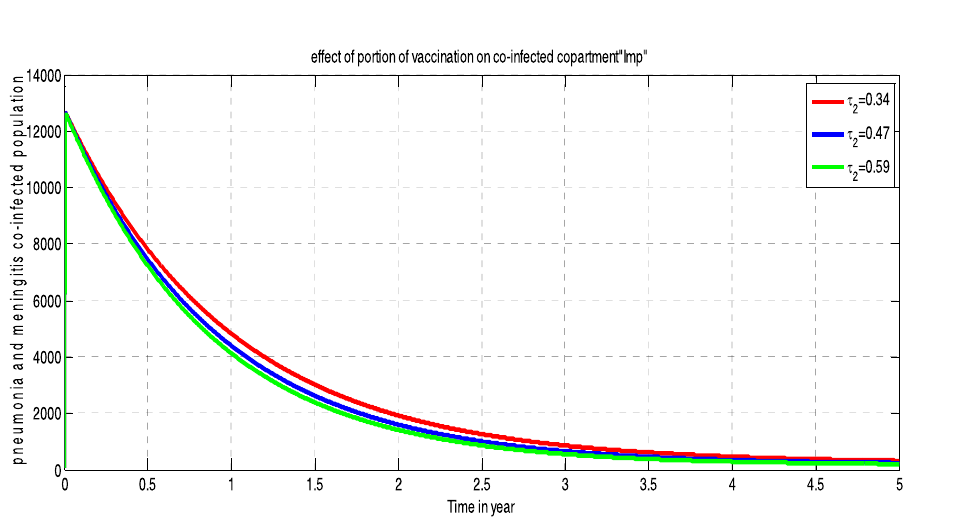
Figure 11. Effect of portion of vaccination on co-infected